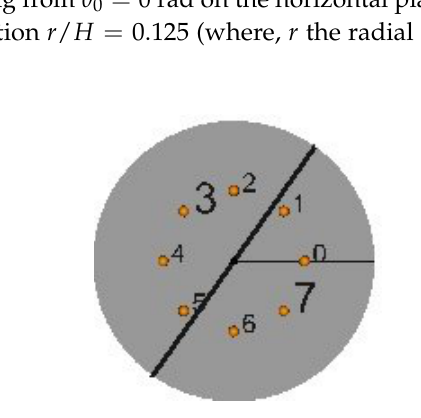
Figure 3. Probe location in the horizontal plane midway between the lower and upper